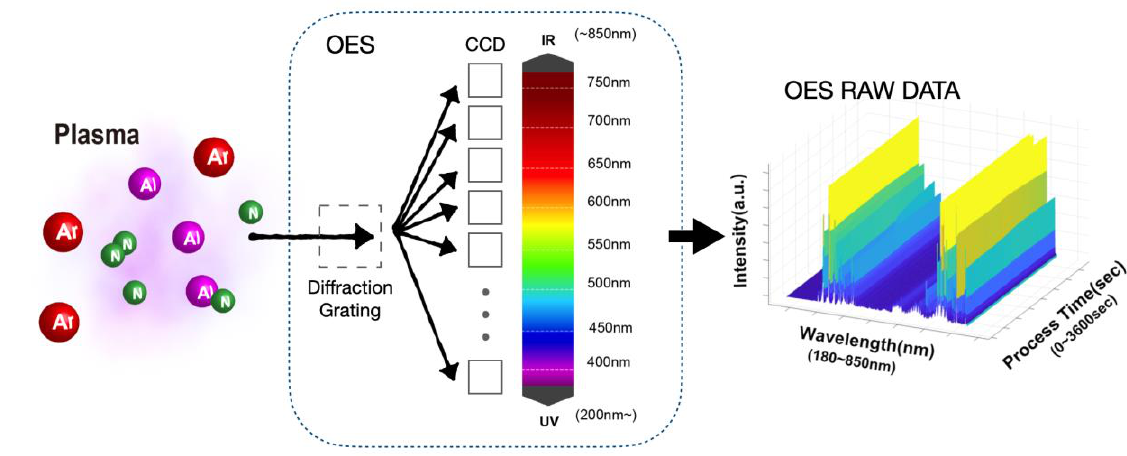
Figure 2. Methodology of OES data acquirement and a waterfall plot showing raw data continuously collected by the spectrometer during a 60-min process.